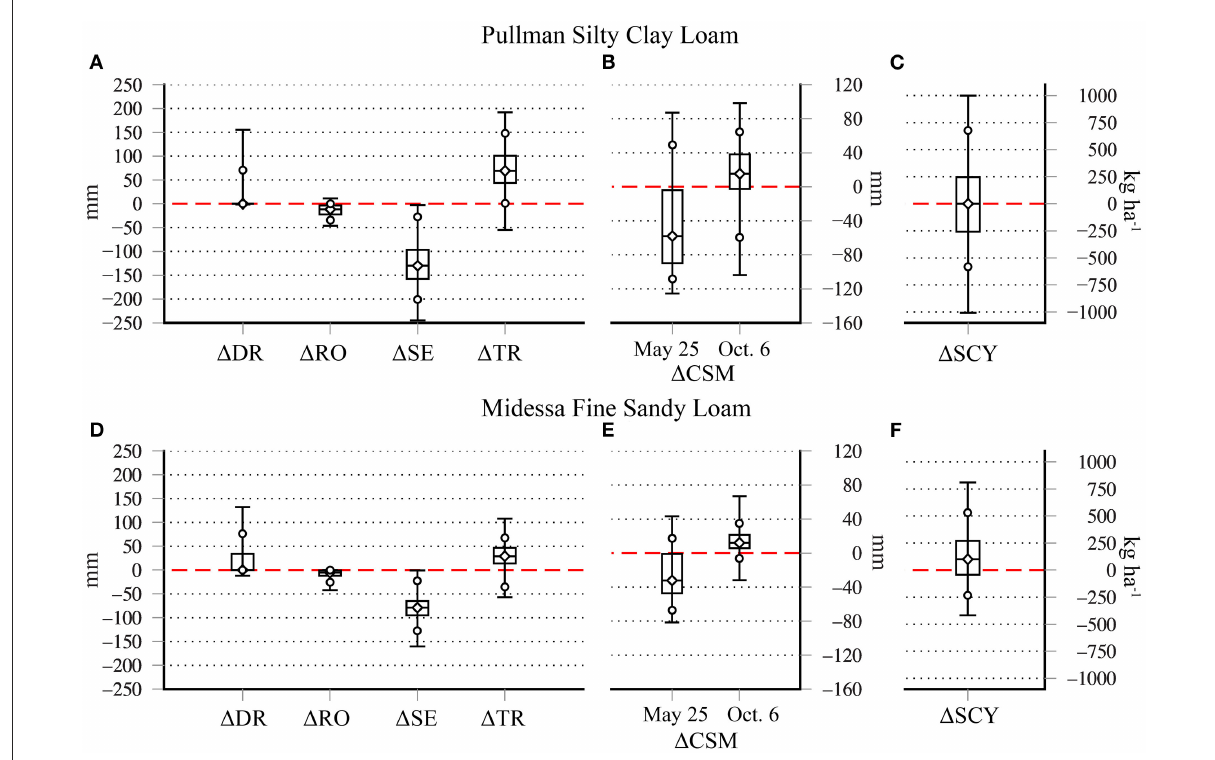
FIGURE6 (A) Distributions of MO 17 WHCO-FACO management effects on cumulative drainage ( 1 DR), runoff ( 1 RO), surface evaporation ( 1 SE), and transpiration ( 1 TR) during cotton planting to cotton harvest for the PSCL soil. (B) Distributions of column soil moisture effects ( 1 CSM) at MO 17 cotton planting (May 25) and harvest (Oct. 6) dates. (C) Distribution of MO 17 seed cotton yield effects ( 1 SCY). (D) Distributions of MO 18 WHCO-FACO management effects on cumulative drainage ( 1 DR), runoff ( 1 RO), surface evaporation ( 1 SE), and transpiration ( 1 TR) during cotton planting to cotton harvest for the MFSL soil. (E) Distributions of column soil moisture effects ( 1 CSM) at MO 18 cotton planting (May 25) and harvest (Oct. 6) dates. (F) Distribution of MO 18 seed cotton yield effects ( 1